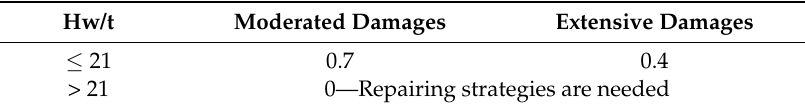
Figure 11. Infill masonry walls numerical modelling strategy: equivalent one strut model (w—strut width; L w —panel length; H w —panel height; H—inter-storey height; L—storey length). Table 2. R 2 reduction factor.